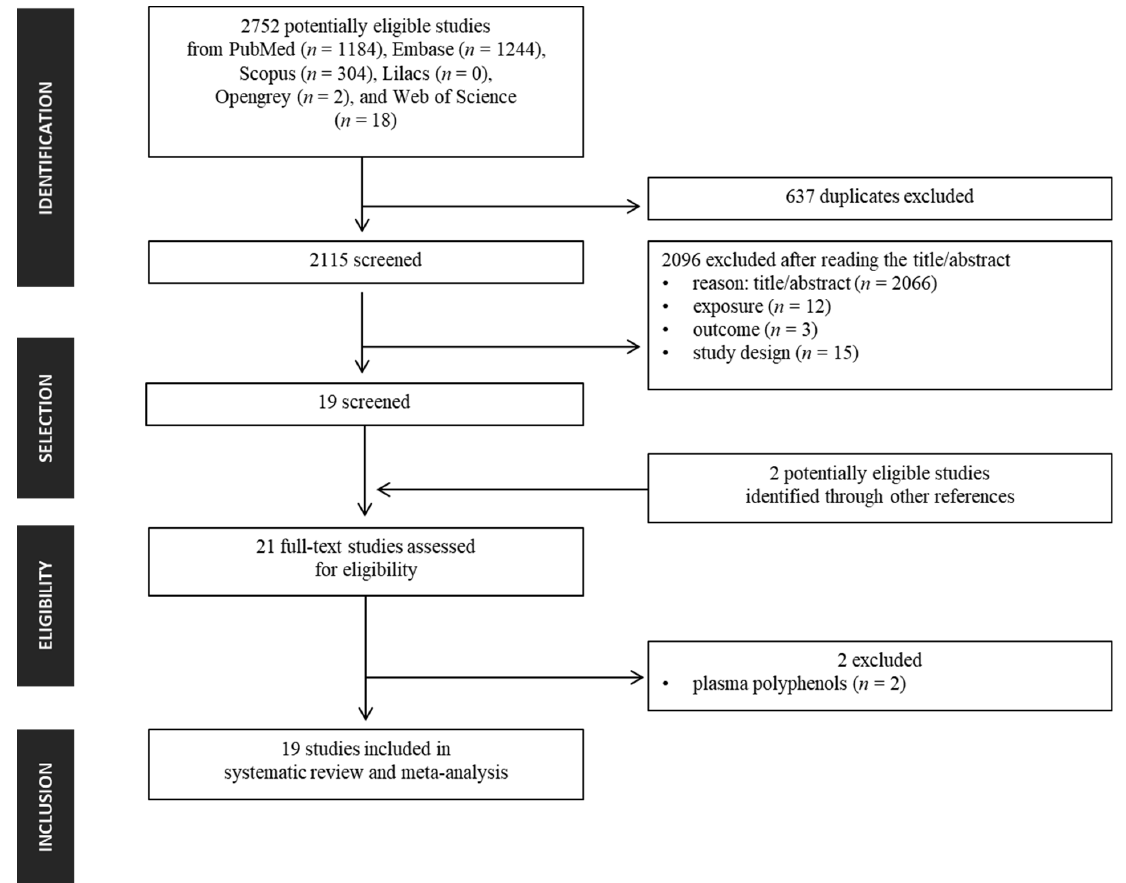
Figure 2. Flow diagram of selection of eligible studies for inclusion in systematic review according to PRISMA guidelines.